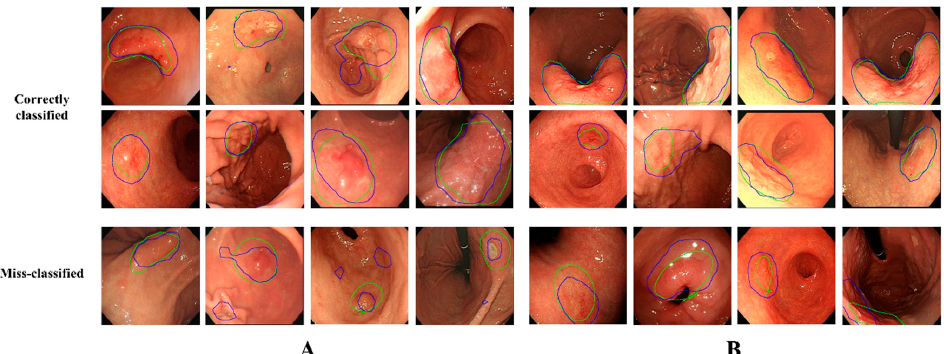
Figure 2. Classification results of lesion-based VGG-16. The green lines indicate the actual early gastric cancer (EGC) regions. The blue lines indicate the activated regions at testing. The first two rows are images precisely classified to their own classes, whereas the last row shows misclassified images. ( A ) EGC detection. ( B ) EGC depth prediction.